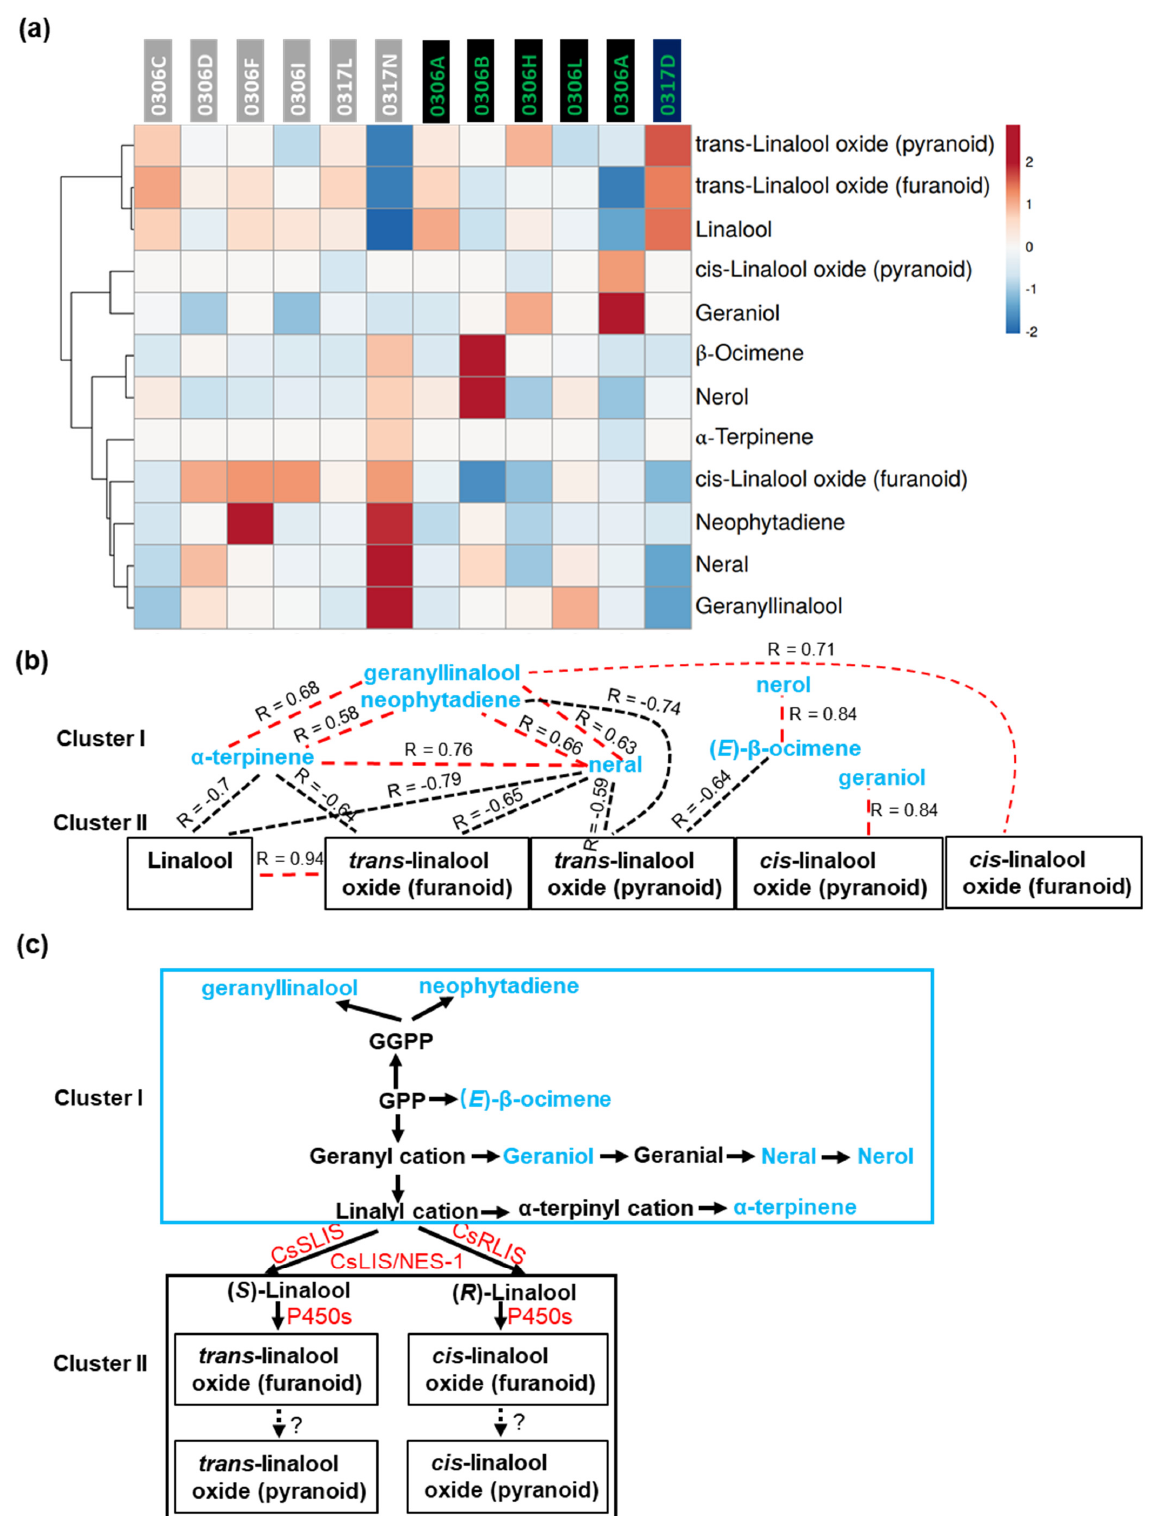
Figure 5. Monoterpene and diterpene volatile clustering patterns based on correlation types and connectivity. ( a ) HCA and heat map analysis of volatile metabolites of the MEP pathway. ( b ) The correlations between cluster I and cluster II metabolites of the MEP pathway. The red dashed lines represent a significant positive correlation; the black dashed lines represent a significant negative correlation. ( c ) Proposed MEP synthesis